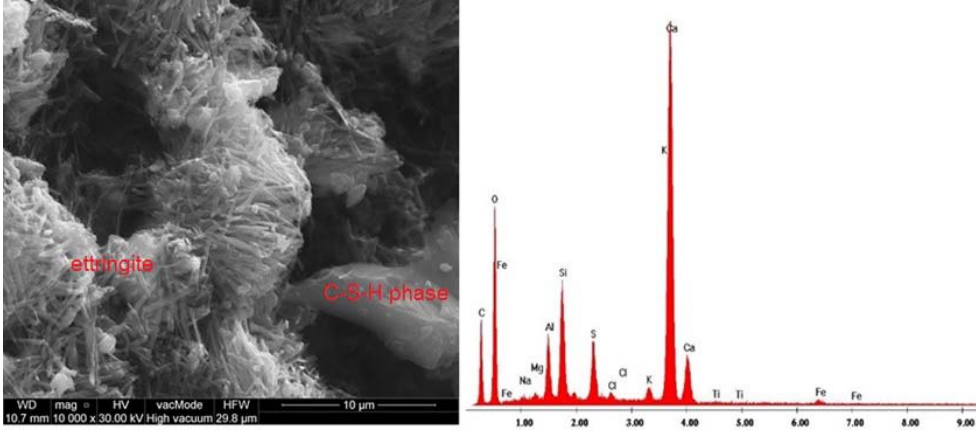
Figure 8. Microstructure of SCC C5P1b and EDS elemental analysis area rich in ettringite crystals between aggregated clusters of C-S-H phases (×10,000).